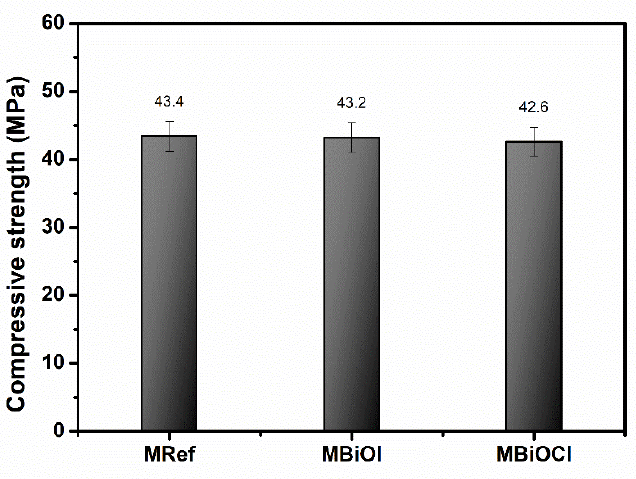
Figure 5. Compressive strength properties of reference (MRef) and photocatalytic mortars prepared with 10% of the photocatalyst (BiOI or BiOCl) at the age of 28 days.